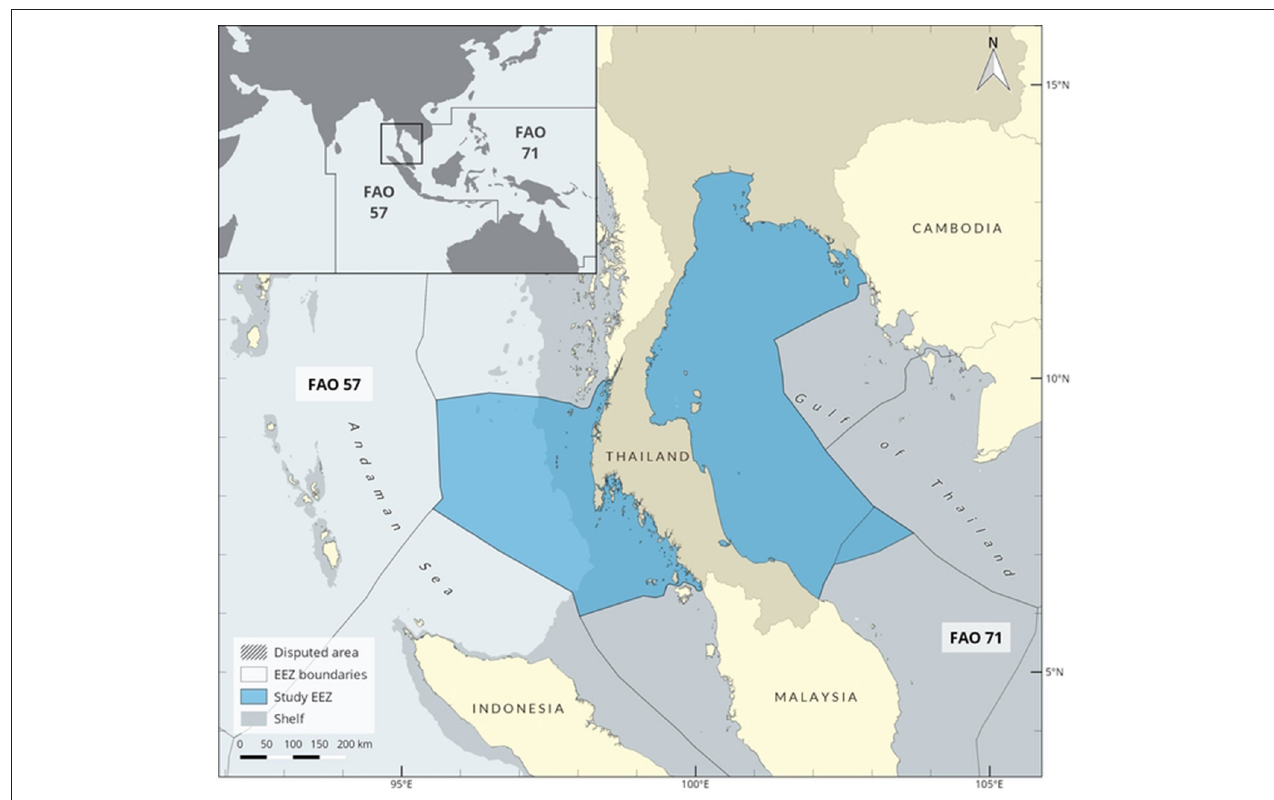
FIGURE 1 | Thailand’s Exclusive Economic Zone (EEZ) and shelf waters to 200m depth, in both the Andaman Sea (Eastern Indian Ocean, FAO area 57) and the Gulf of Thailand (Western Central Pacific, FAO area 71). Overlapping EEZ claims are